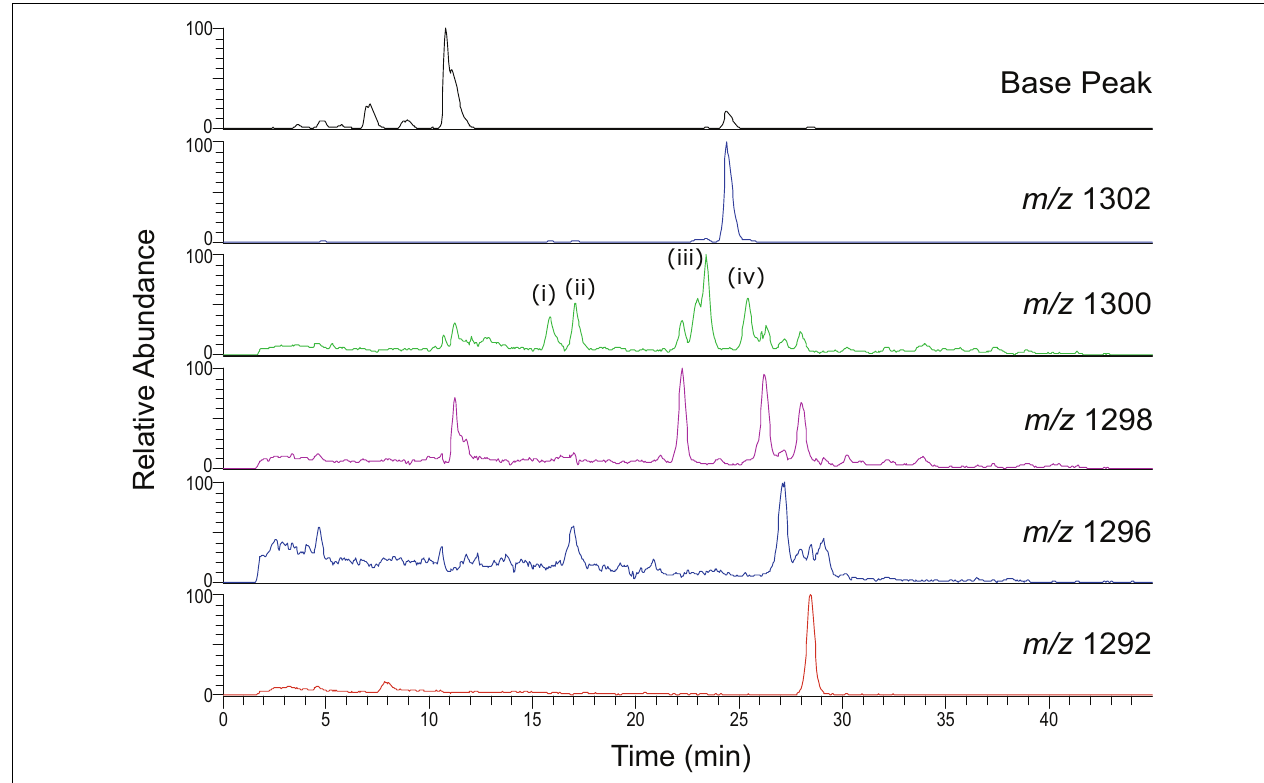
FIGURE 5 | HPLC-MS Single Ion Monitoring chromatograms from a C18-XB analysis of the Swedish peat bog extract, showing multiple isoGDGT